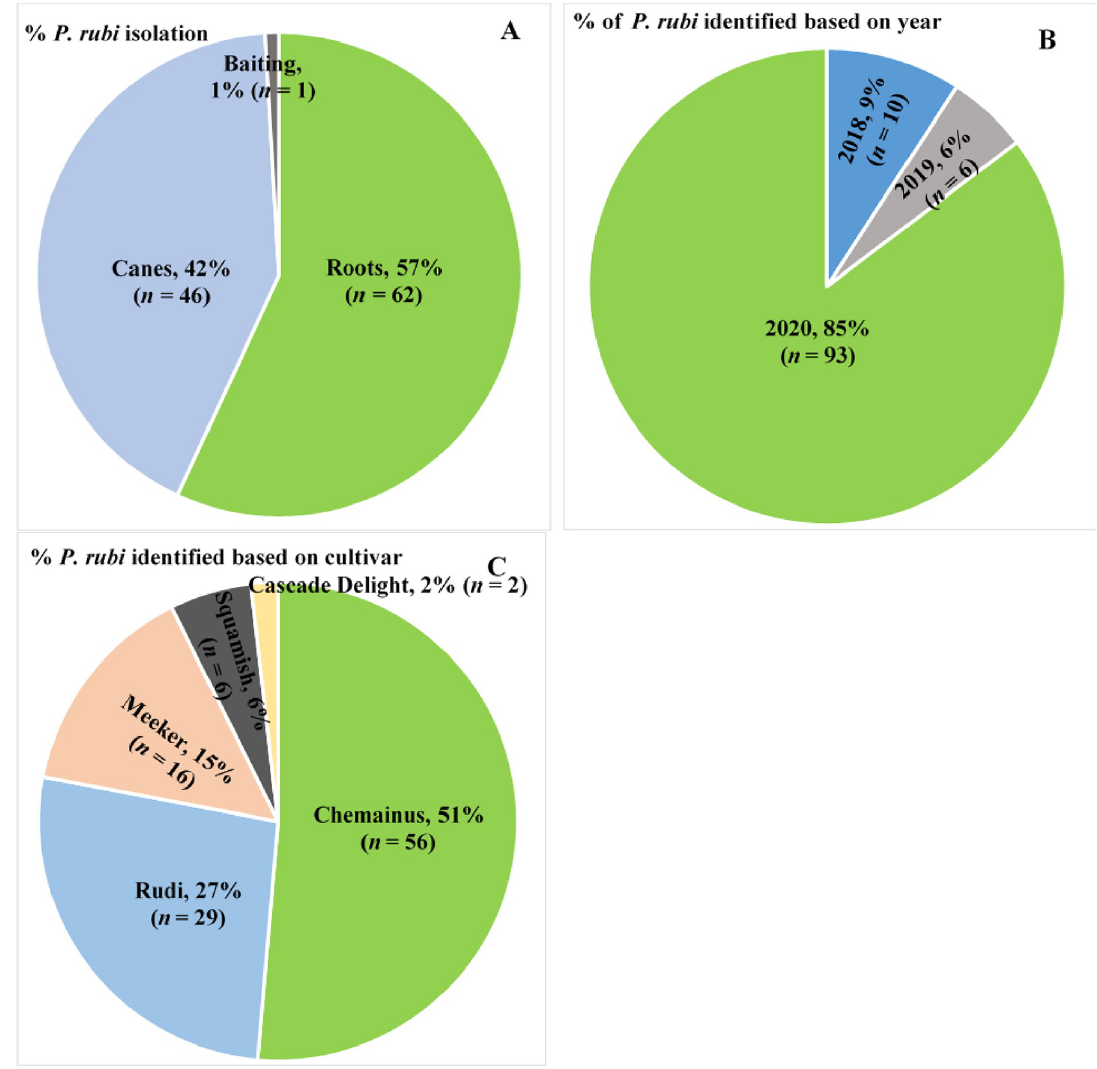
Fig 6. Frequency distribution of Phytophthora rubi infecting raspberry recovered from BC. (A) based on method of isolation. (B) by year. (C) by raspberry cultivars. Data were combined from all three years to compare isolation methods and raspberry